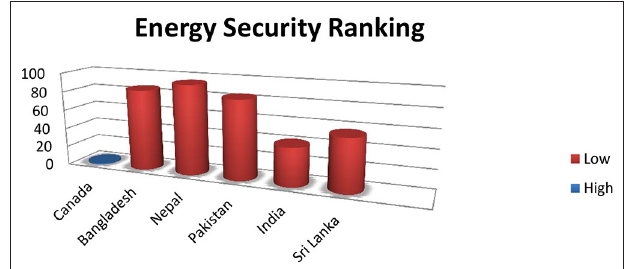
FIGURE 1 | Higher numbers denoting insecurity, compared with Canada: (16).